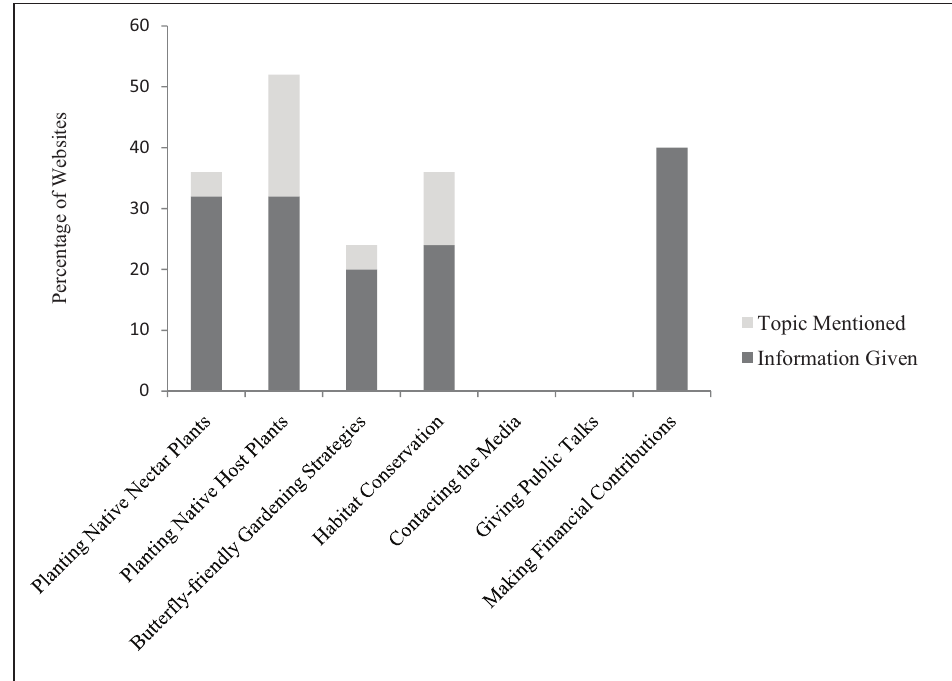
Figure 3: Percentage of project websites providing information on or mentioning butterfly conservation actions, n =